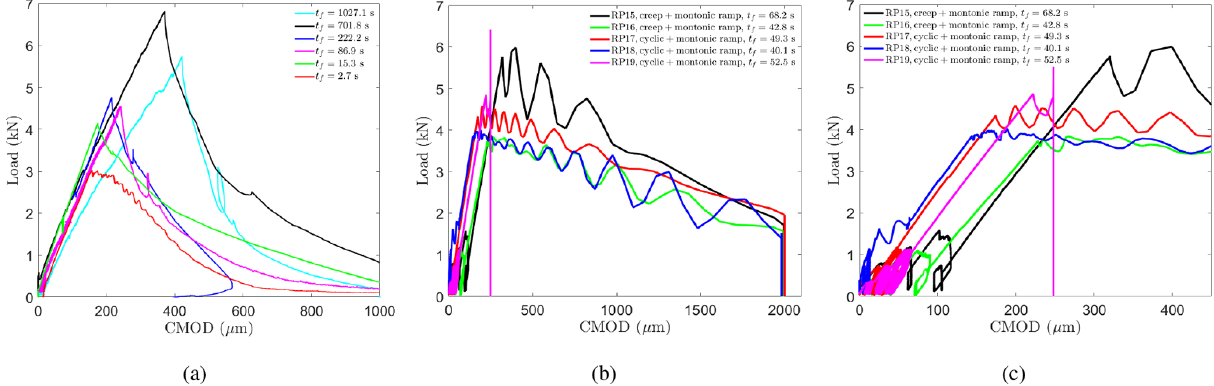
Figure 5. Measured load versus CMOD for the (a) DC tests (Gharamti et al., 2021), (b) LC tests, and (c) LC tests up to the peak load.